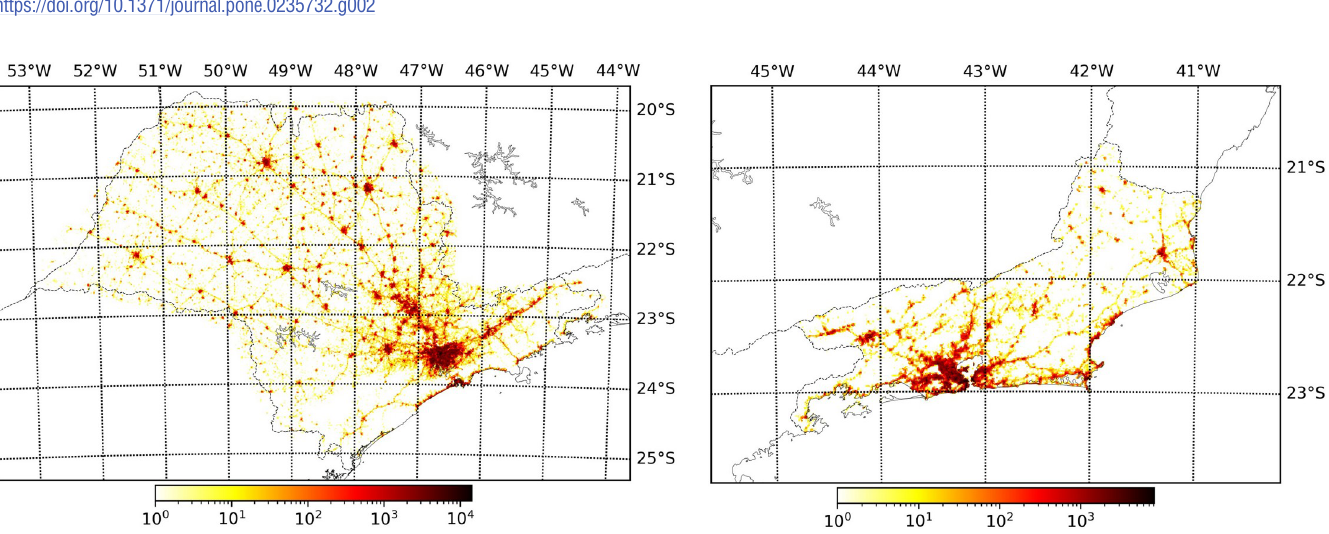
Fig 3. Typical distribution of the location of app usage in one day for the states of S ã o Paulo (left) and Rio de Janeiro (right) considering a resolution of 0.01 degree on each geographical coordinate. This data refers to March 1 st , 2020 and the color represents the number of recordings, first or subsequent, in each location.